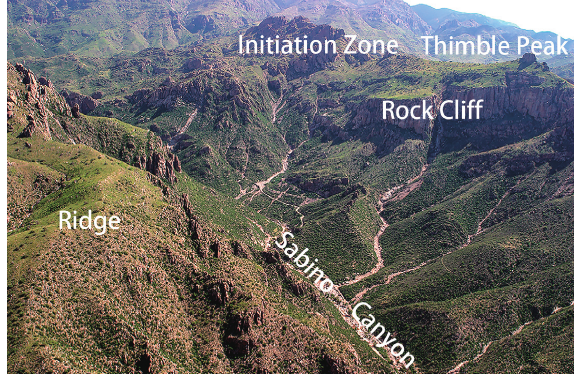
Figure 3: Slope failures and debris flows along the east side of Sabino Canyon. Photograph obtained from Magirl,